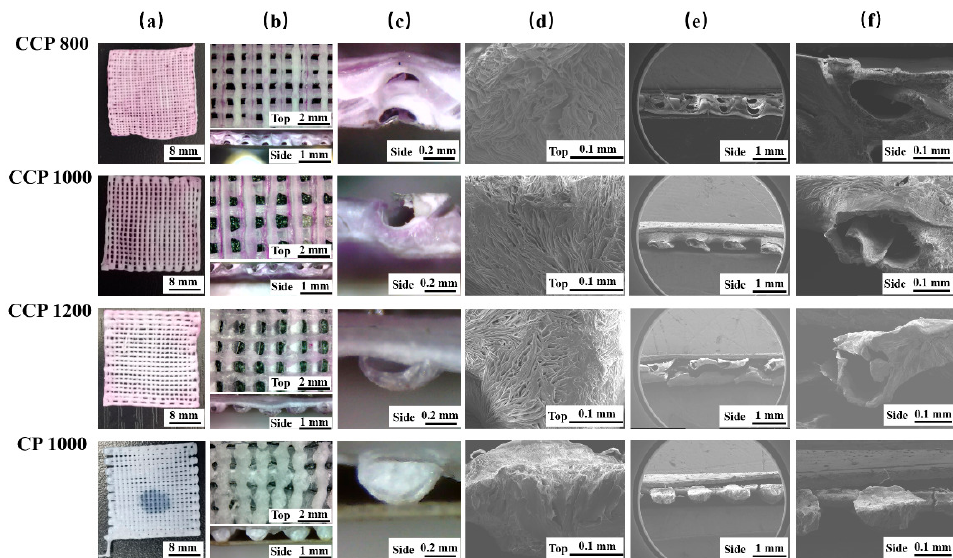
Figure 4. Morphology of CCP 800, CCP 1000, CCP 1200, and CP 1000 scaffolds. ( a ) Top view of overall scaffolds; ( b ) top and side views of an area of scaffolds; ( c ) the coaxial structure of fibers in scaffolds; ( d ) the micropores on printed fiber surface; ( e ) the side view of scaffolds; ( f ) the shell and core coaxial structure of the printed fiber of scaffolds.